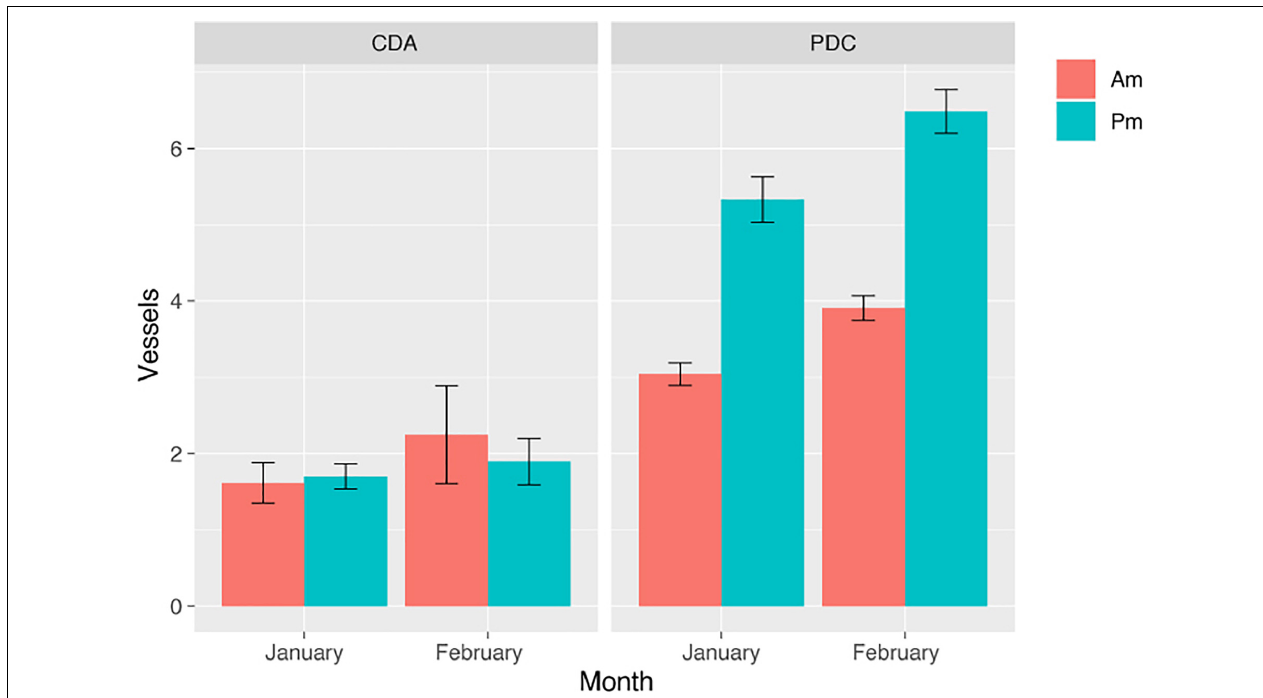
FIGURE 7 | Number of vessels present at each encounter with the dolphins in T2 for both the Chañaral de Aceituno (CDA) and Punta de Choros (PDC) coves, time of day (AM and PM), and January and February. The error bar indicates the standard deviation.